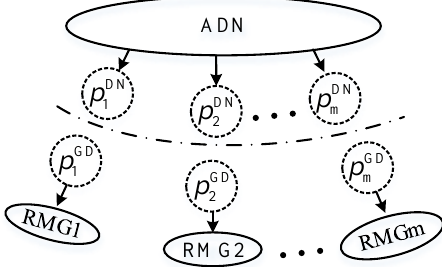
Figure 4. Decoupling scheme of ADN and RMGs.